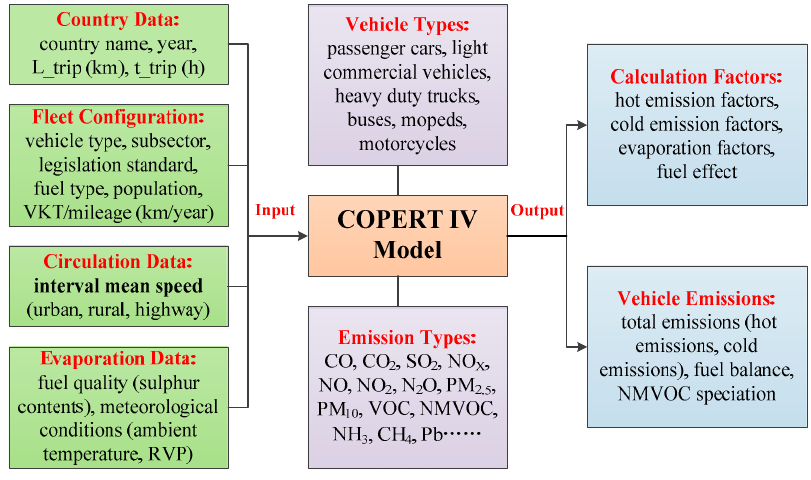
Figure 1. The specific input and output of COPERT IV model.